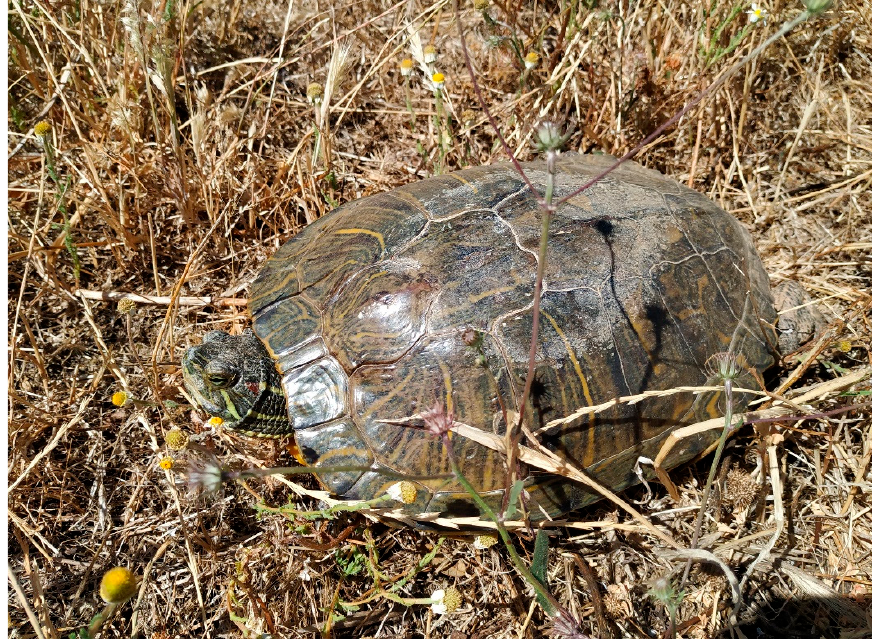
Figure 6. Individual of yellow eared terrapin observed on the farm. Author: Jesús Barrena González.